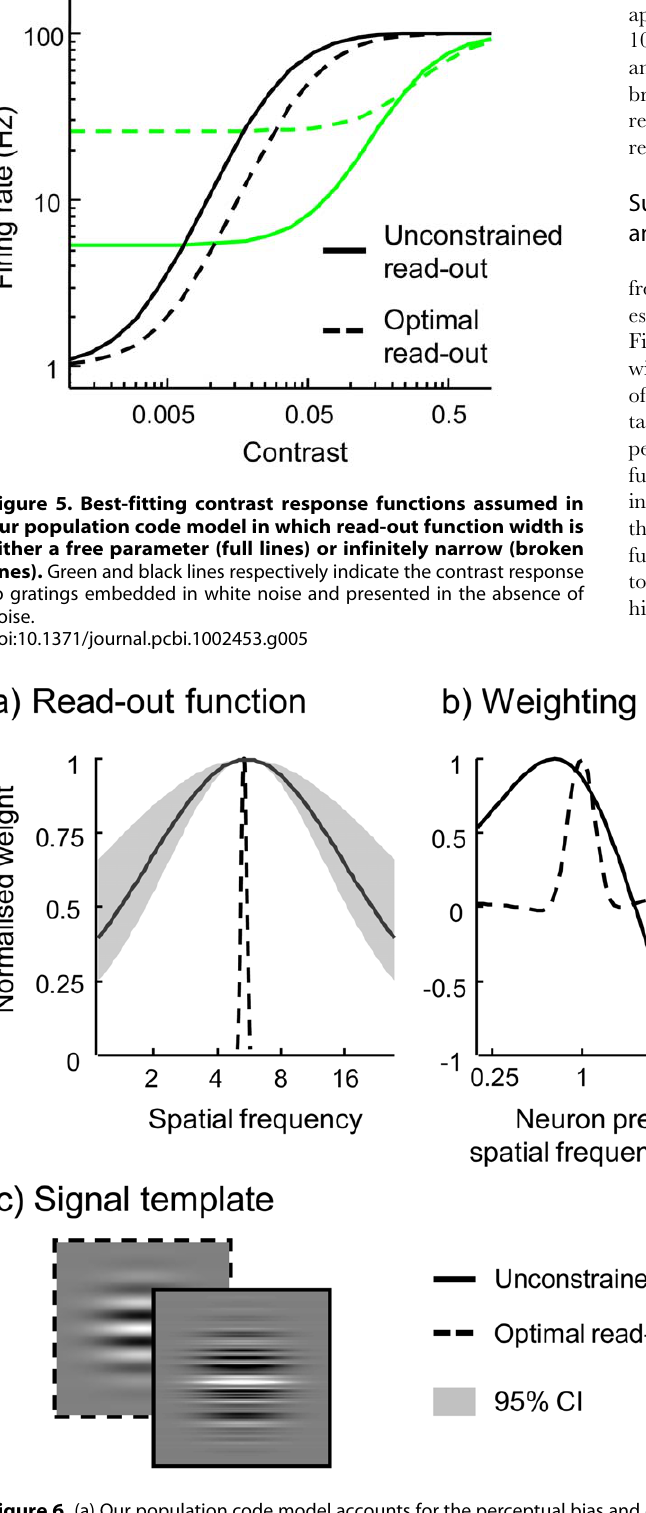
PLoS Computational Biology |